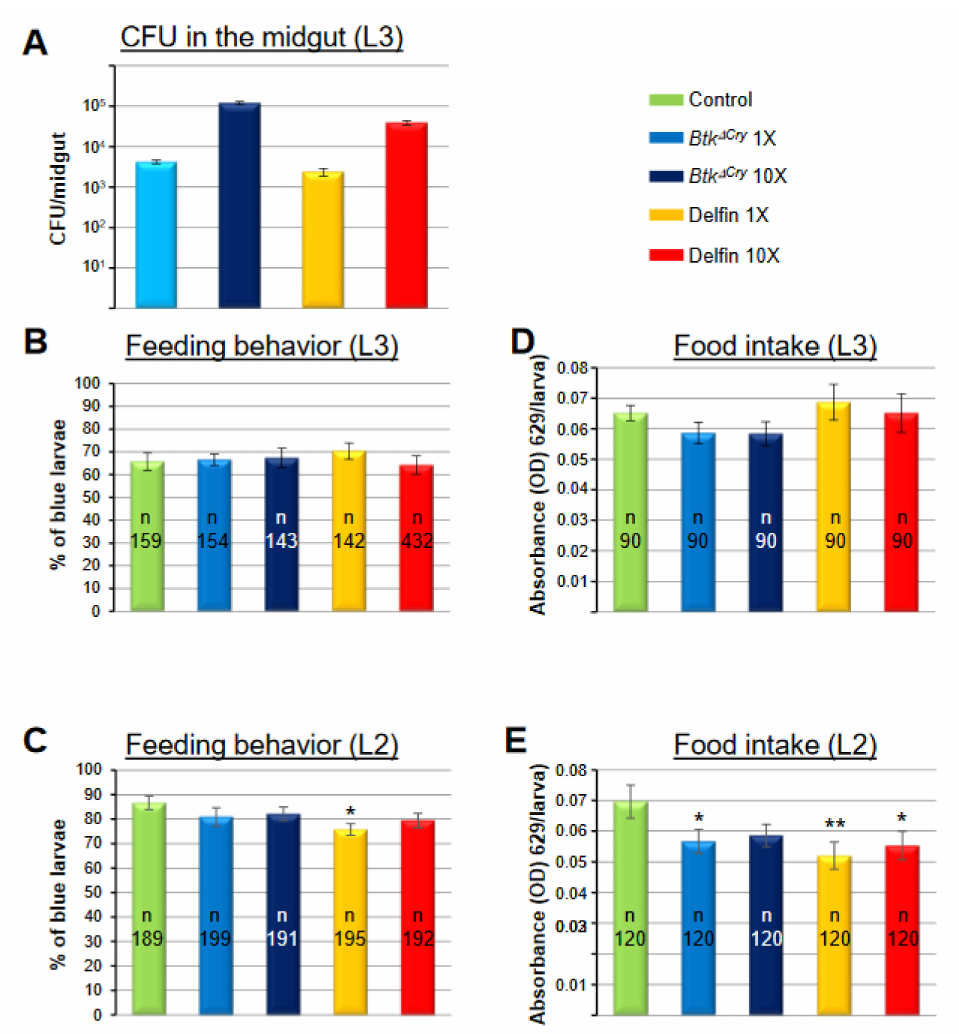
Figure 2. Btk bioinsecticides and larval feeding behavior. ( A ) L3 midgut load of larvae fed with either spores of Btk ∆ Cry or Delfin. ( B , C ) Percentage of L3 ( B ) and L2 ( C ) presenting blue dyed food in the intestine. ( D , E ) Amount of dye ingested by L3 ( D ) and L2 ( E ). Green bars: Control larvae (fed with water); light blue bars: 1X concentration of Btk ∆ Cry spores; dark blue bars: 10X concentration of Btk ∆ Cry spores; yellow bars: 1X concentration of Delfin; Red bars: 10X concentration of Delfin. N = number of individuals analyzed. Errors bars represent the SEM. * p < 0.05, ** p < 0.01 compared with